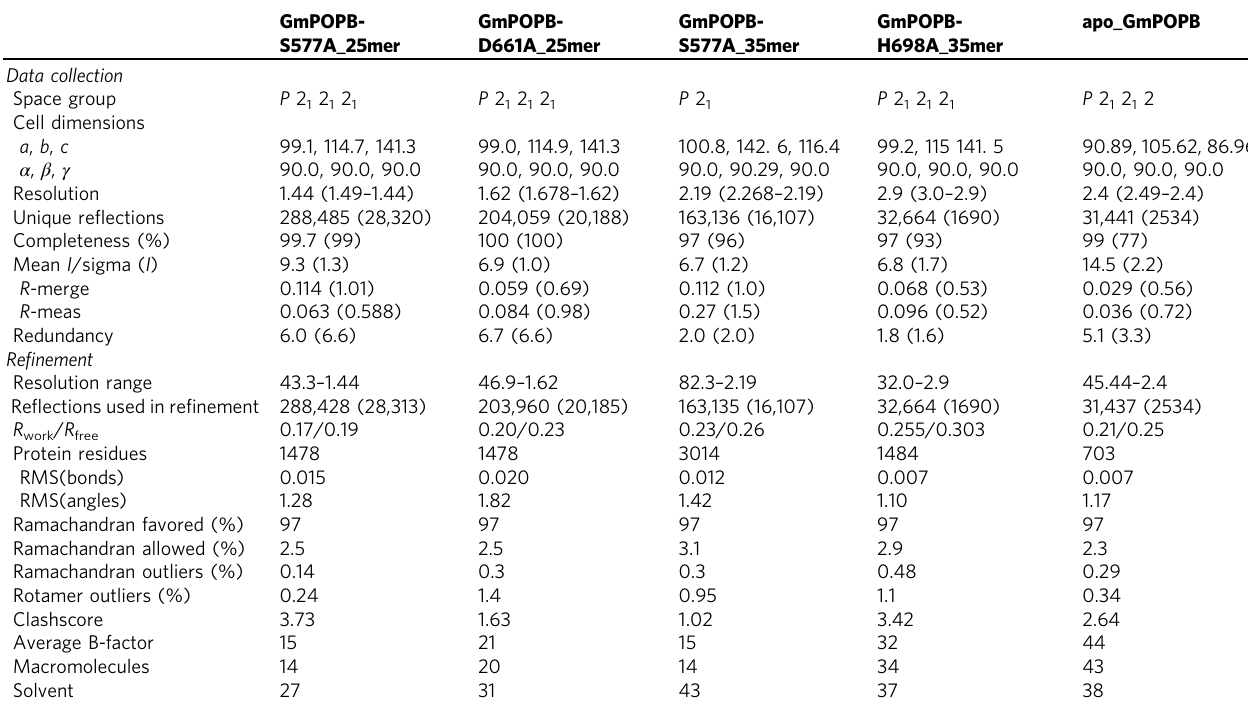
Table 1 Data collection and re fi nement